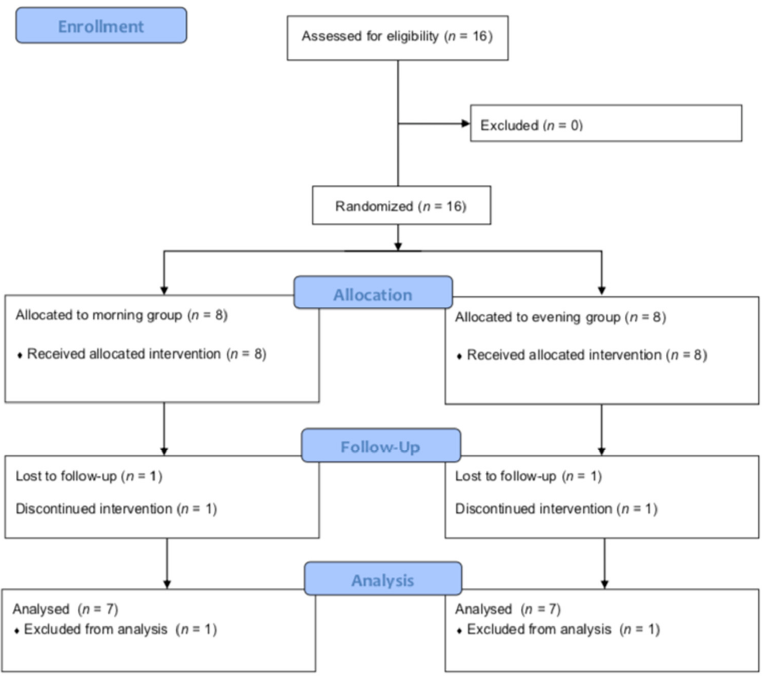
Figure 1. Flow Diagram CONSORT.